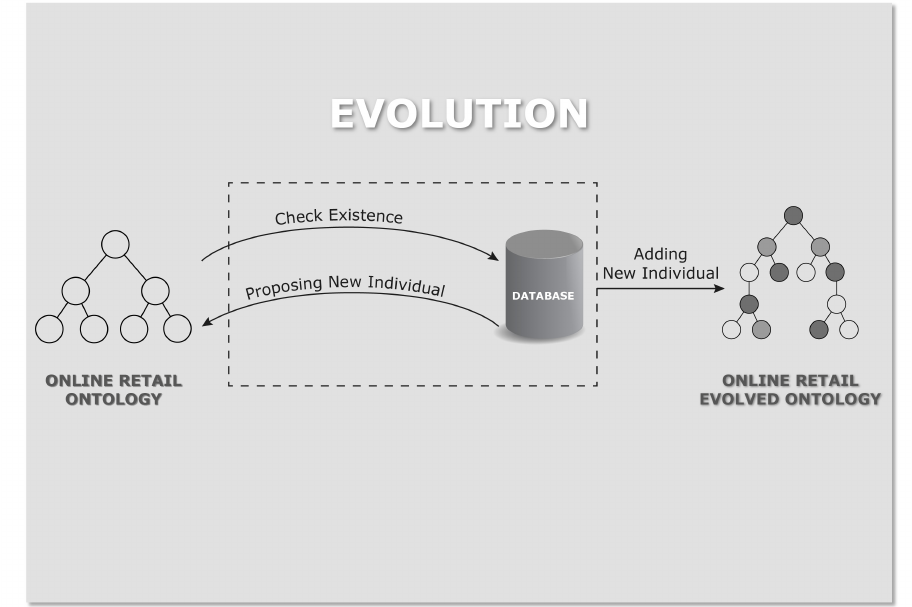
Figure 9. Proposed subsystem architecture for the ontology